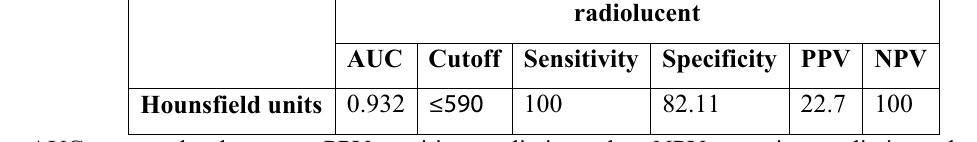
Fig. 4 ROC curve of radiolucency in the PKUB about its density in Hounsfield units